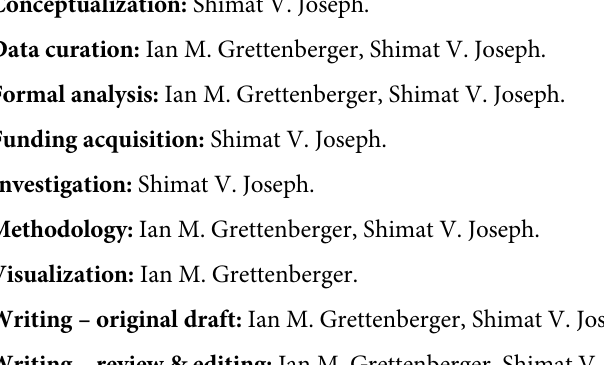
S1 Table. Replicate numbers for laboratory and outdoor experiments. Number of replicates for each stage and starvation treatment combination for analyses of total distance moved for the laboratory experiment and for analyses of total distance and turning ratio from the field experiment. S1 Fig. Relationship between wind speed and air and surface temperature to account for missing wind data. To account for missing wind data, we fit a regression model to predict wind speed based on surface and air temperature measurements ( WS = ST � WS + ST 2 � WS + ST 3 � WS + AT � WS + AT 2 � WS + AT 3 � WS + b ), where WS = wind speed, ST = surface temperature, and AT = air temperature. Data for which wind speed was recorded are shaded shades of blue based on air temperature values. Points shaded red are points for which wind speed was